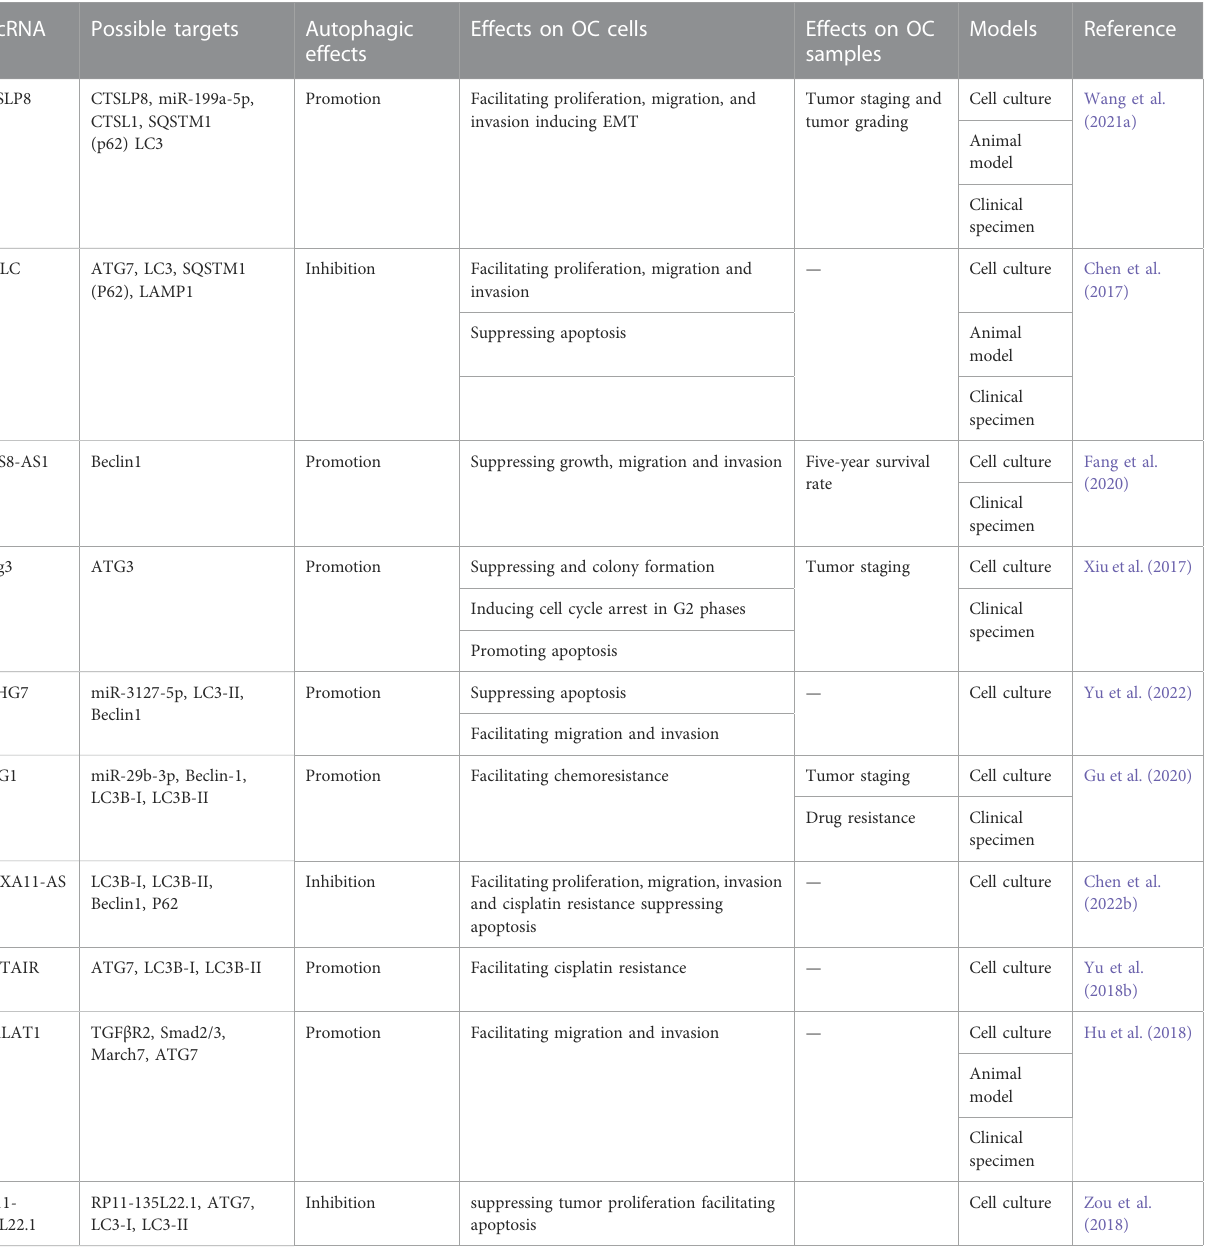
TABLE 2 LncRNAs involved in autophagy modulation in